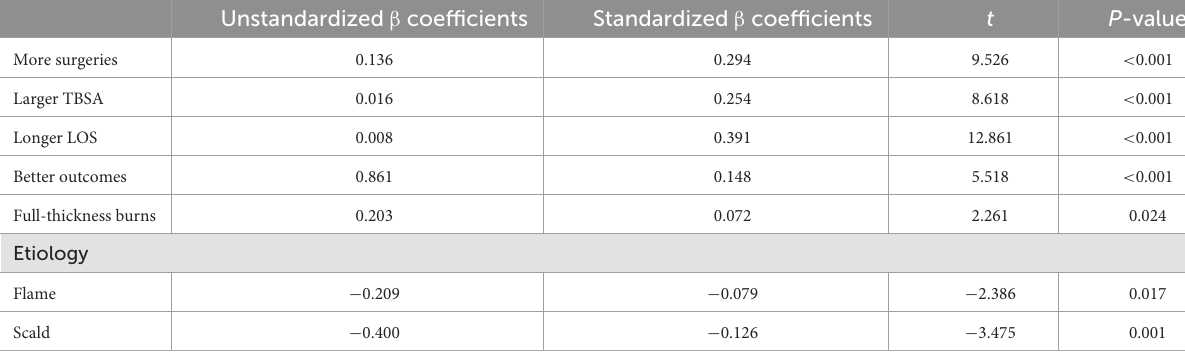
TABLE 6 Risk factors of total medical cost, analyzed by multiple linear